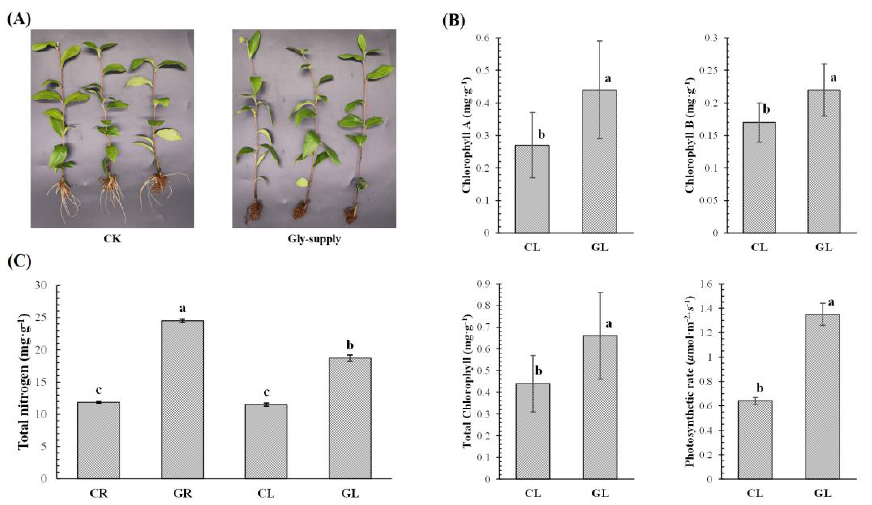
Figure 1. ( A ) Phenotypes of tea plants. ( B ) The chlorophyll contents and net photosynthetic rates of tea leaves. ( C ) The nitrogen contents of tea roots and leaves. Different lowercase letters indicated significant differences according to one-way ANOVA ( p < 0.05). Table 1. Contents of amino acids in tea roots and